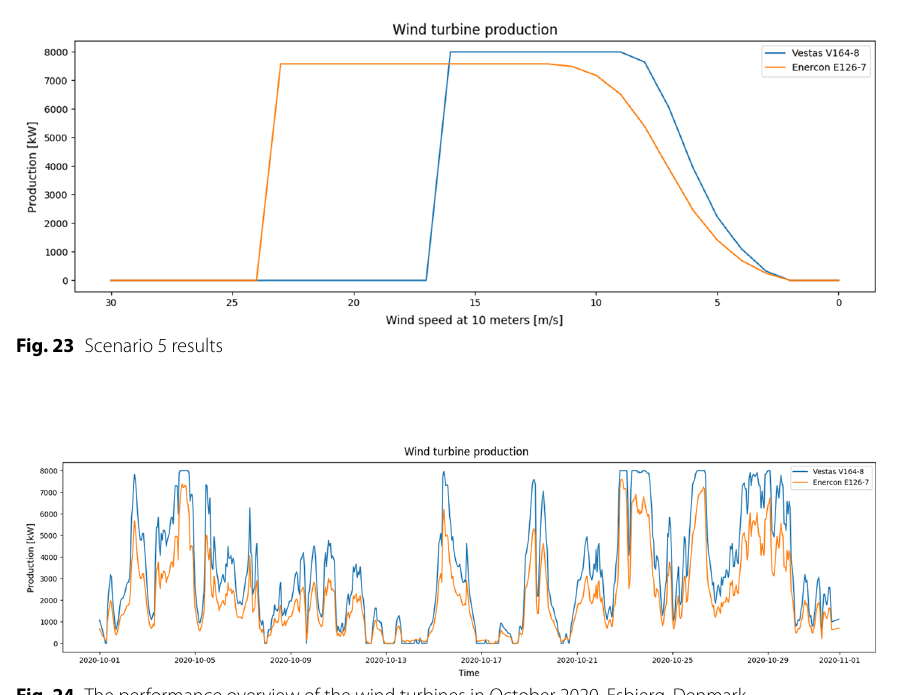
Fig. 24 The performance overview of the wind turbines in October 2020, Esbjerg, Denmark